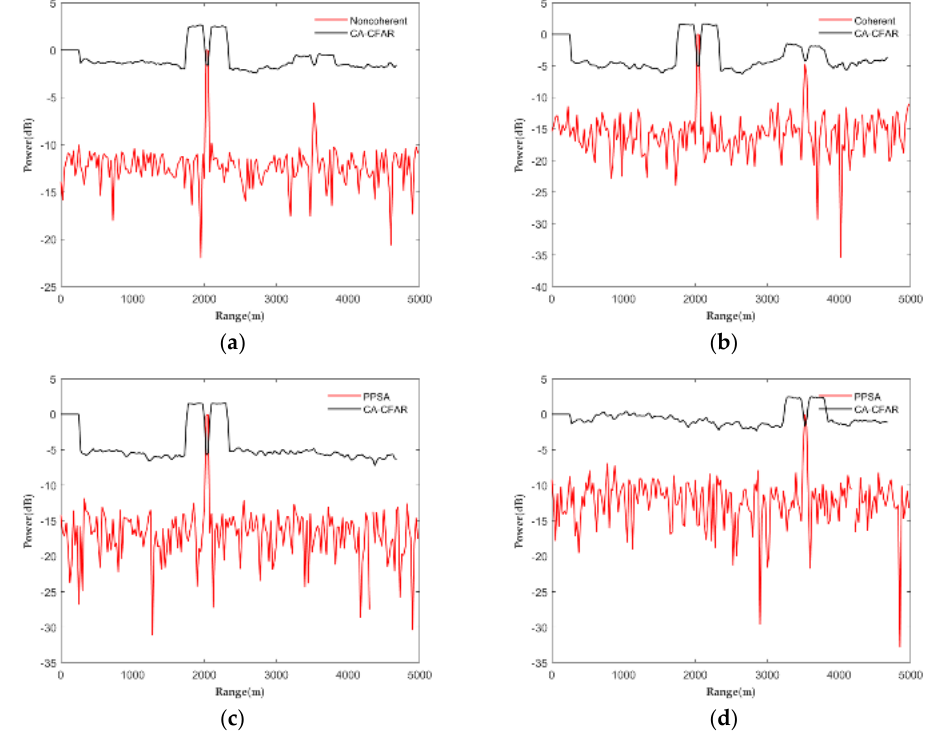
Figure 8. The CFAR detection results for incoherent accumulation, coherent accumulation and PPSA.